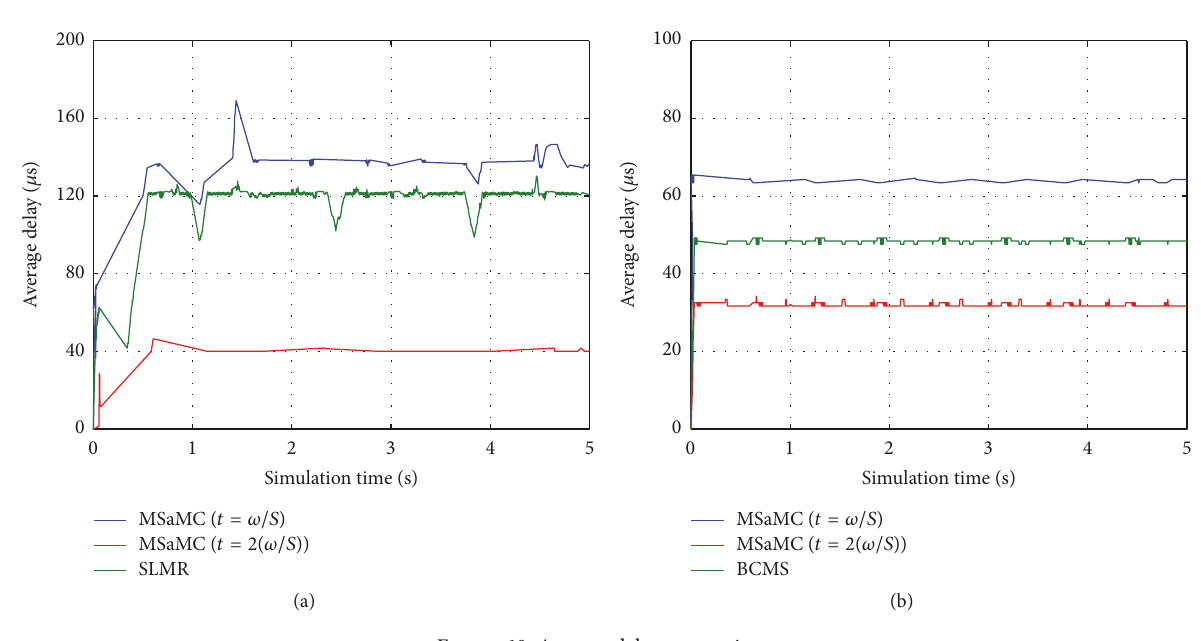
Figure 9: Network throughput comparison.